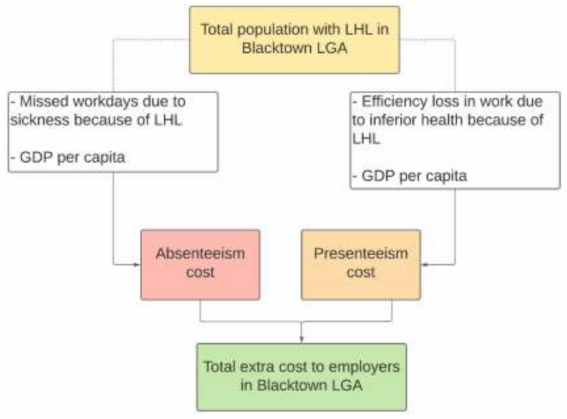
Figure 3. Estimating the economic cost of LHL to the employer/business.